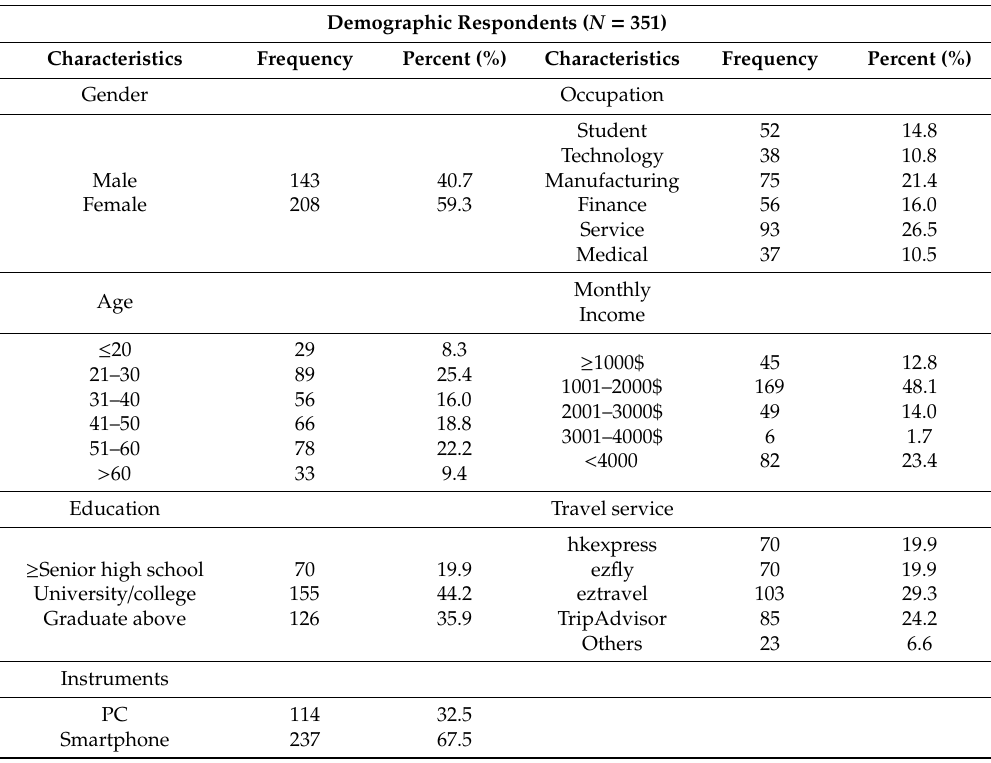
Table 2. Demographics of the